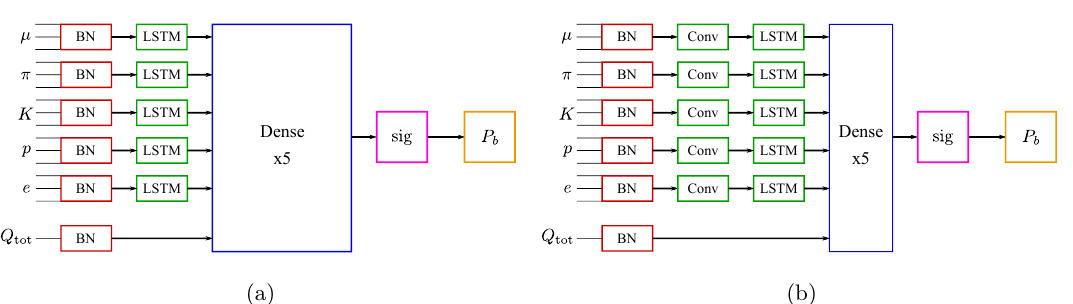
Figure 13. DNN structure.